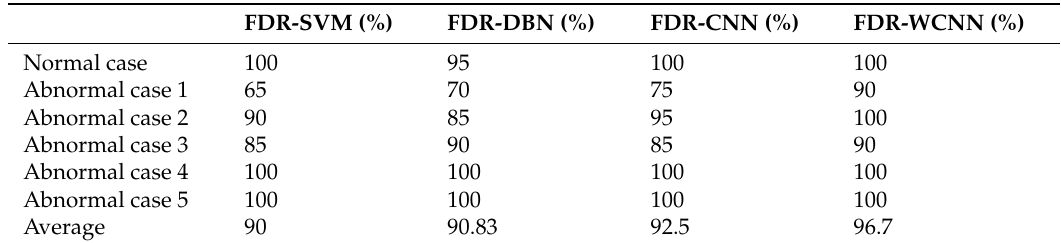
Table 3. The monitoring performance of R-22 process obtained by support vector machine (SVM), deep belief network (DBN), CNN and WCNN.